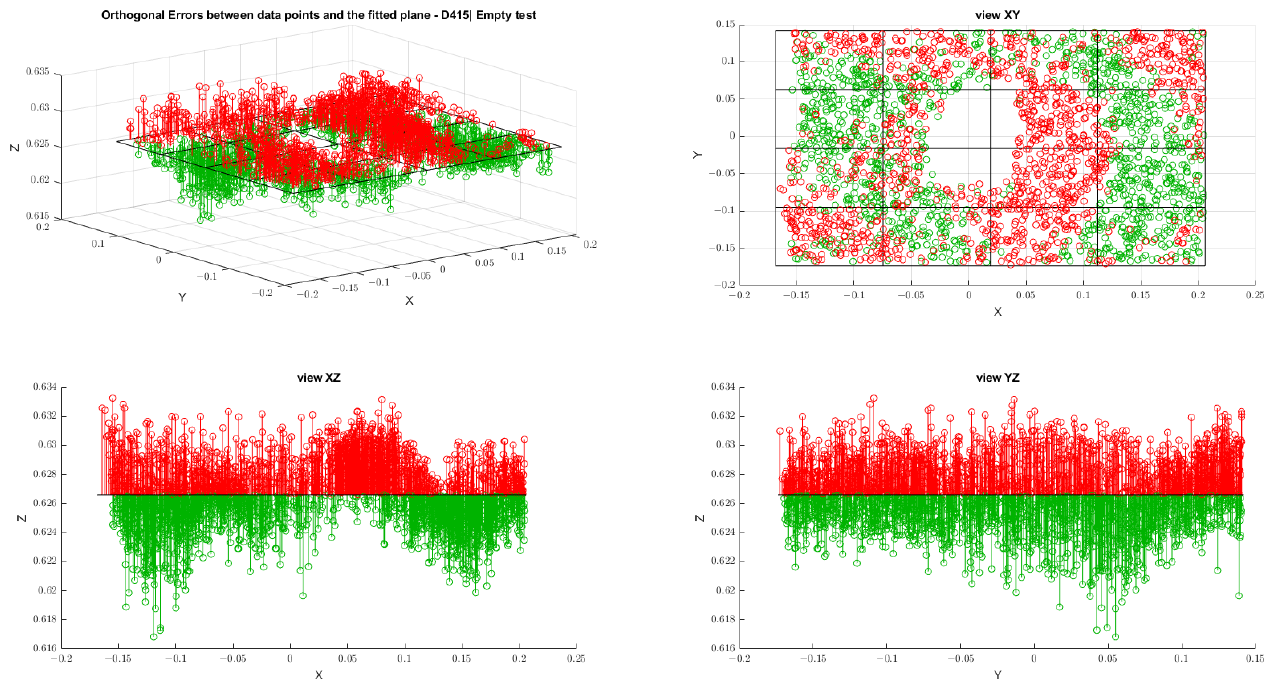
Figure A2. Results of orthogonal errors for the D415 camera referring to the empty